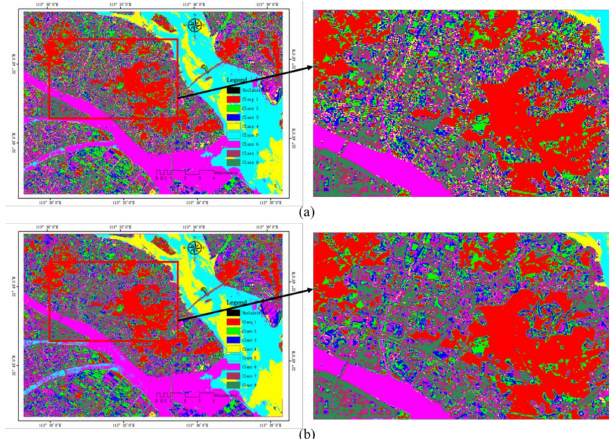
Figure 9. Comparison of the classification results between the images before and after super-resolution. Figure ( a ) is the classification result on the image before super-resolution and Figure ( b ) is the classification result on the image after